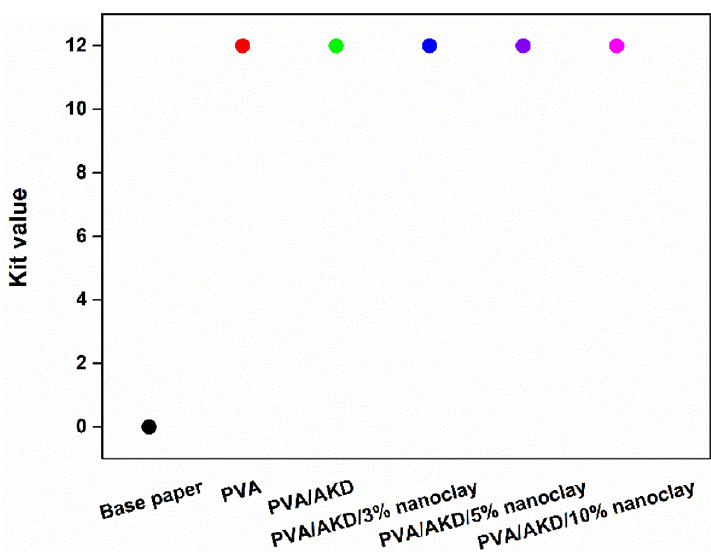
Figure 9. Kit values of the base paper and coated papers in grease resistance testing.